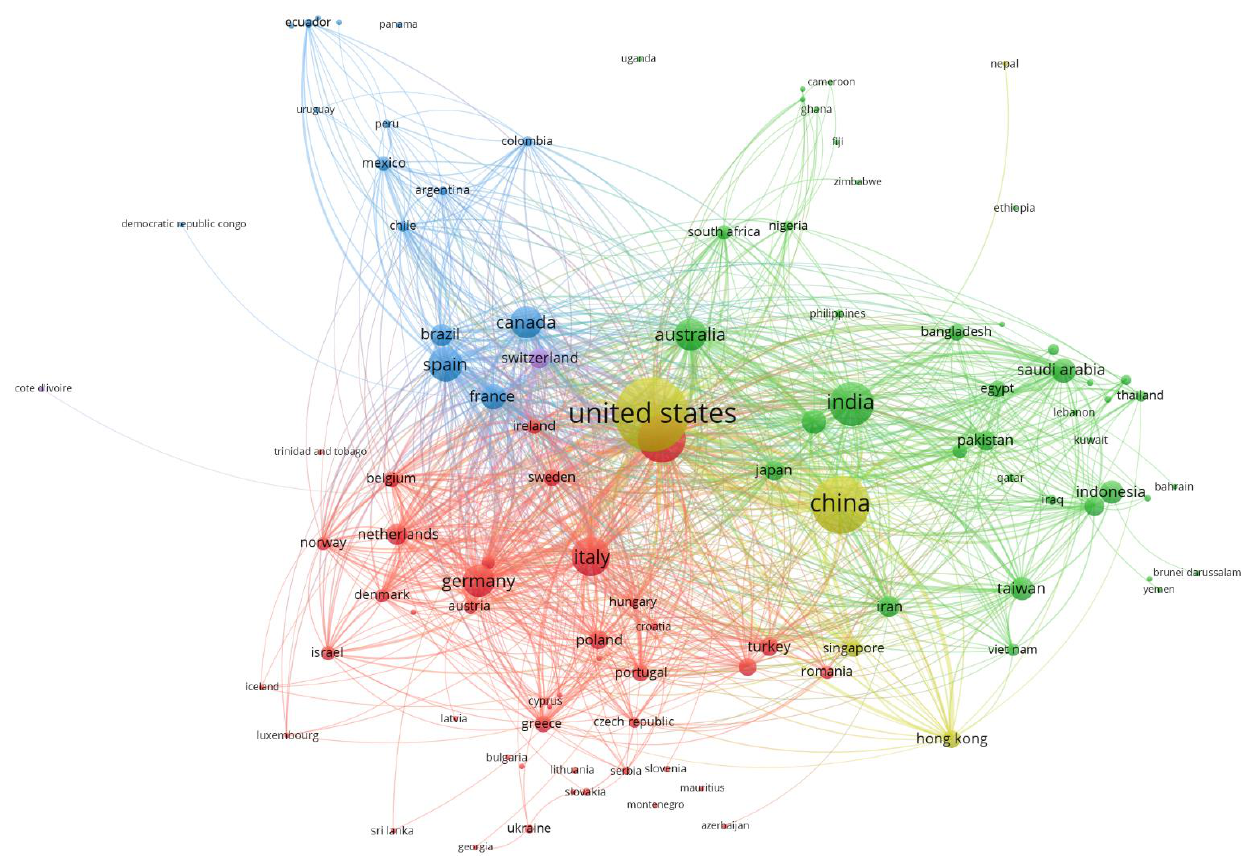
Figure 5. Co-authorships by countries (source Scopus).